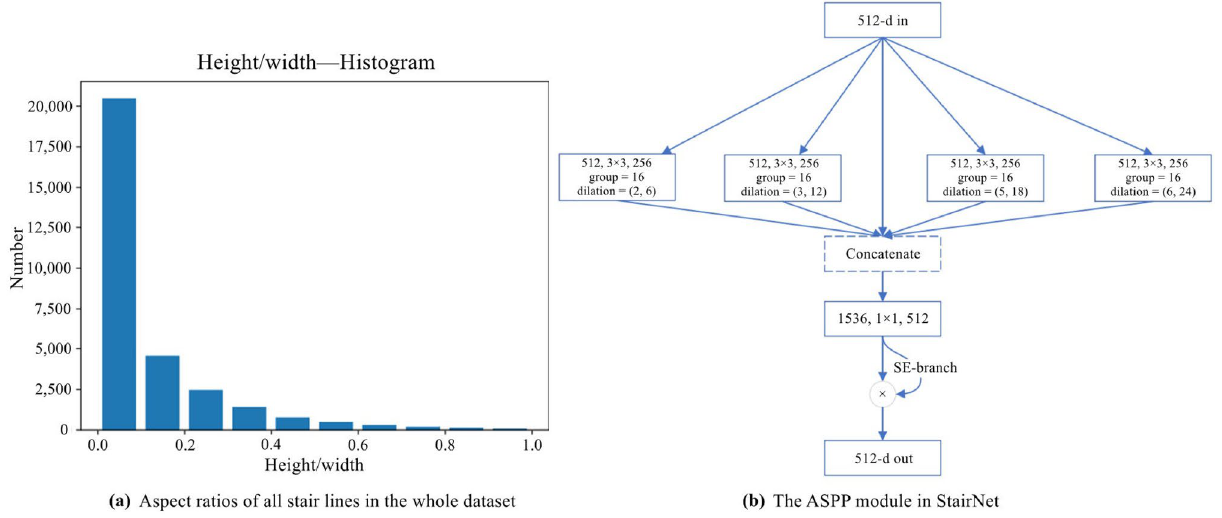
Figure 4. ( a ) The aspect ratios of all stair lines in the whole dataset. The aspect ratios of most stair lines are within the range of 0–0.2. ( b ) The ASPP module in StairNet: Our ASPP module has five branches, including an input feature map and group dilated convolutions with dilation rates of (2,6), (3,12), (5,18) and (6,24). At the end of the module, a channel attention mechanism is added to learn the emphasis placed on context information extraction at different scales. A layer is denoted as (input channels, filter size, output tion of the ResNeXt block. We build an inception module by applying group dilated convolutions with different dilation rates in the horizontal and vertical directions. Specifically, we concatenate the calculation results of standard dilated convolutions and the calculation results of dilated convolutions with different dilation rates in the horizontal and vertical directions, and then we apply a channel attention mechanism to learn the weights of the concatenated channels. Figure 5 shows the structure of Bottleneck 2.7 in Table 1, and other bottlenecks can be obtained in the same way. Similar to the dilation rates in the ASPP module in “ASPP module”, we consider that the distributions of stairs in the dataset are usually transverse. To use this prior knowledge, we calculate asymmetric dilated convolutions with dilation rates of (1,2), (2,4), (3,8), and (4,16) and their corresponding standard dilated convolutions and